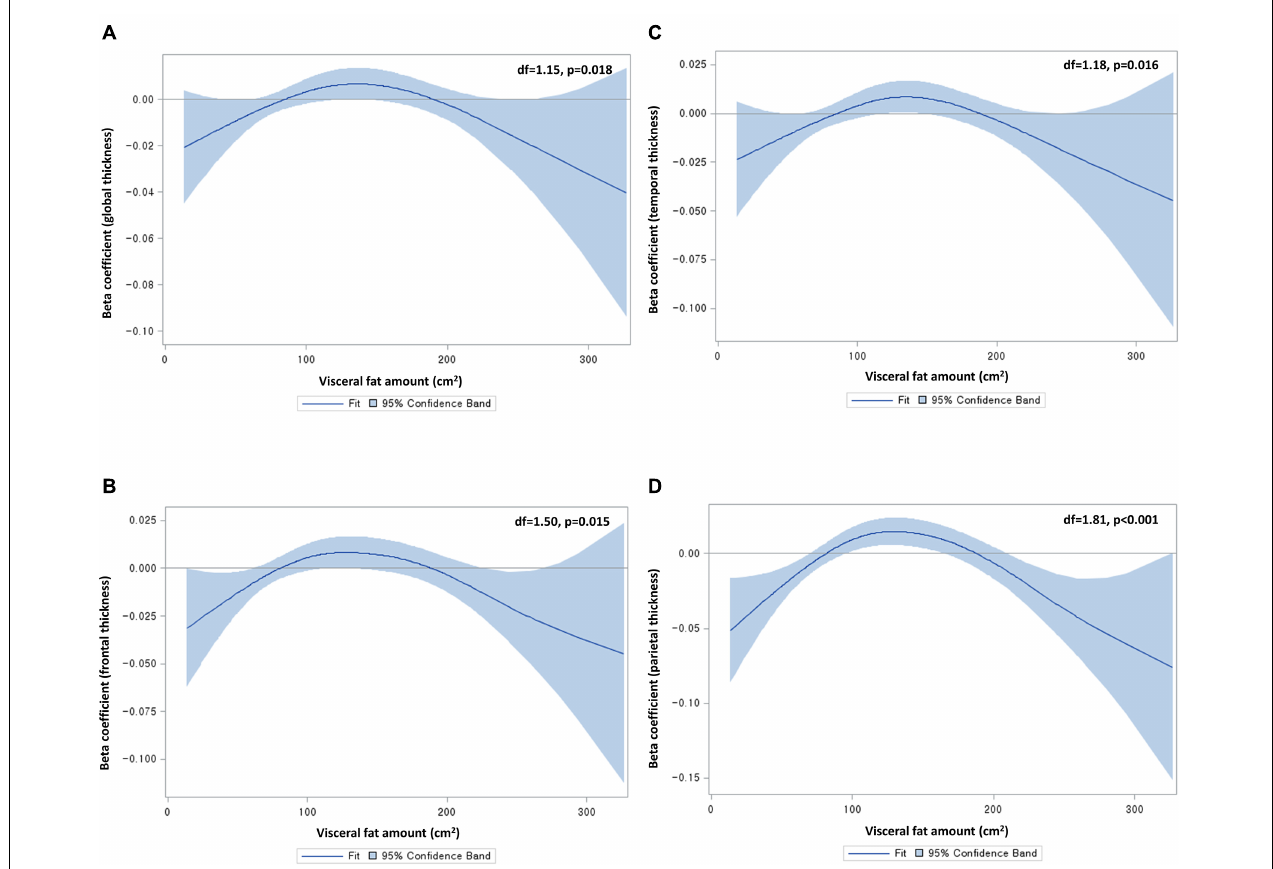
FIGURE 1 | Non-linear relationships of visceral fat area with (A) global, (B) frontal, (C) temporal, and (D) parietal cortical thicknesses. Df, degrees of freedom. Beta coefficients were from generalized additive models, adjusting for age, sex, educational years, hypertension, diabetes, dyslipidemia, angina or myocardial infarction, smoking status, alcohol consumption, apolipoprotein status, body mass index, fasting blood glucose level, total cholesterol level, and intracranial volume. Degrees of freedom were determined by the cross-validation